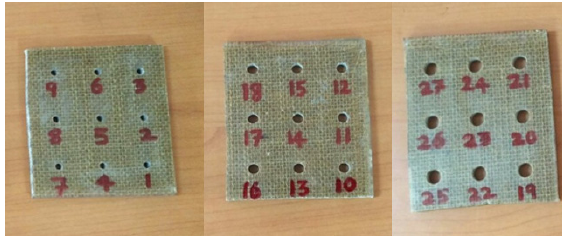
Figure 2. Results of drilling procedure with different parameters The control parameters used are shown in table 1.